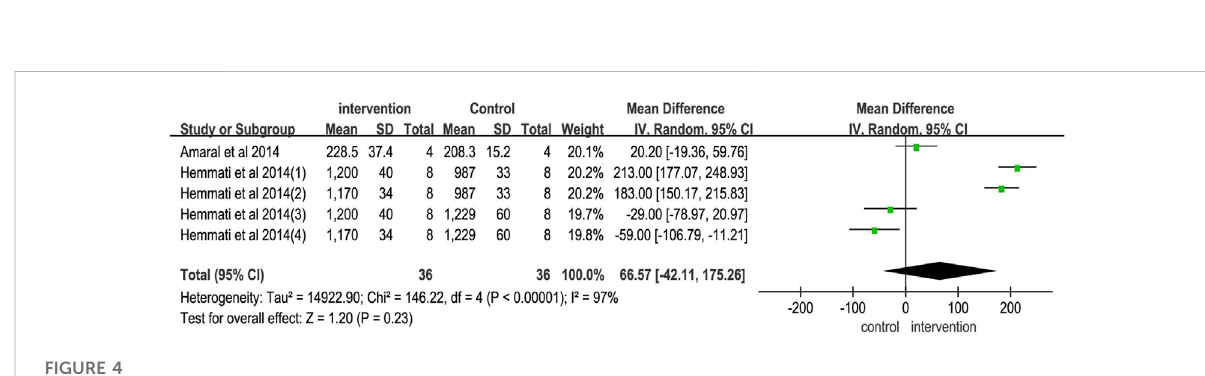
FIGURE 4 Meta-analysis on vitamin K for wound tensile